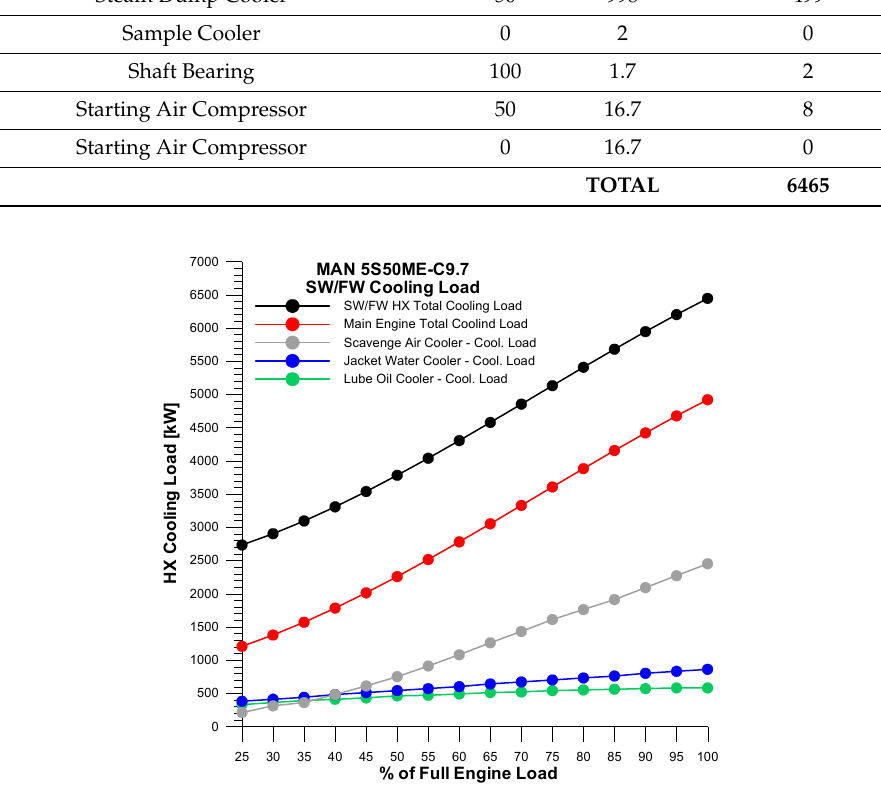
Figure 4. Variation of the total cooling load demand for the central cooling system of a bulk-size carrier equipped with the MAN 5S50ME-C9.7 two-stroke diesel engine